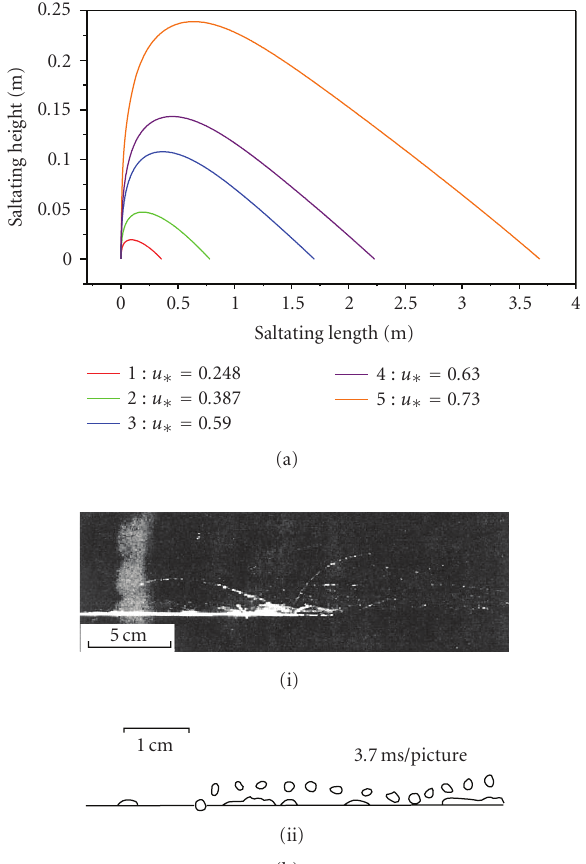
Figure 2: (a) Saltation trajectories at di ff erent friction velocities. (b) (i) Photograph of particle trajectories. (ii) Trace of particle motion on the internal of each spot is 3.7m/s.